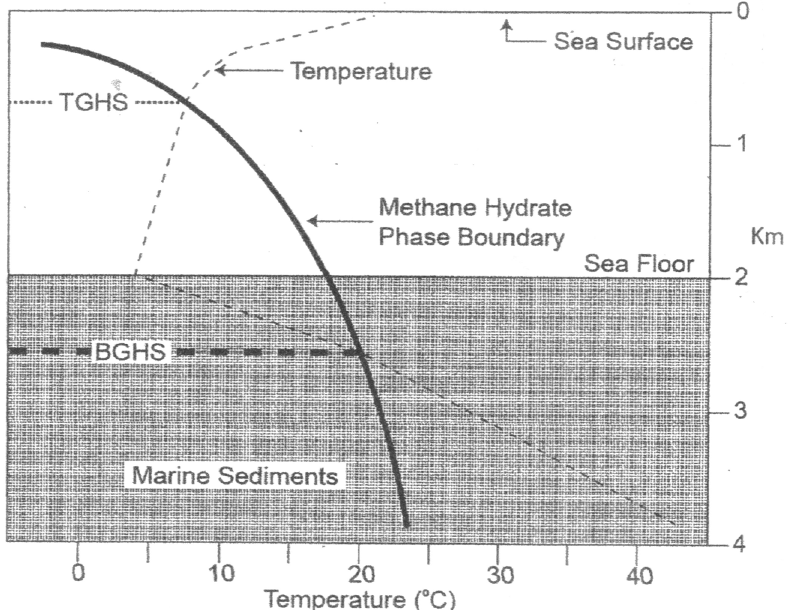
Figure 1. Schematic of the Pressure-Temperature (P-T) phase diagram for oceanic methane hydrate. A seafloor depth of 2000 m is used for illustration purposes (modified after Dillon and Max [14]). * BGHS—Base of Gas Hydrate Stability